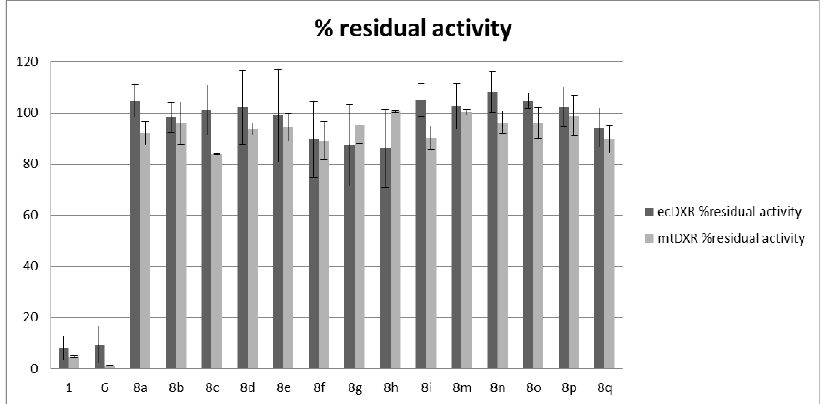
Figure 3. Relative activity of 8a – i, m – q on purified E. coli (dark grey) and Mtb Dxr